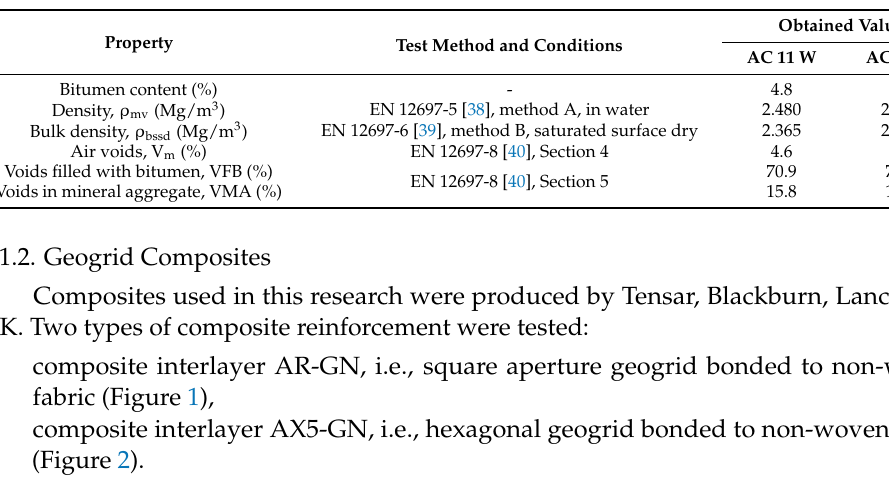
Table 4. Basic volumetric parameters of the asphalt mixtures.